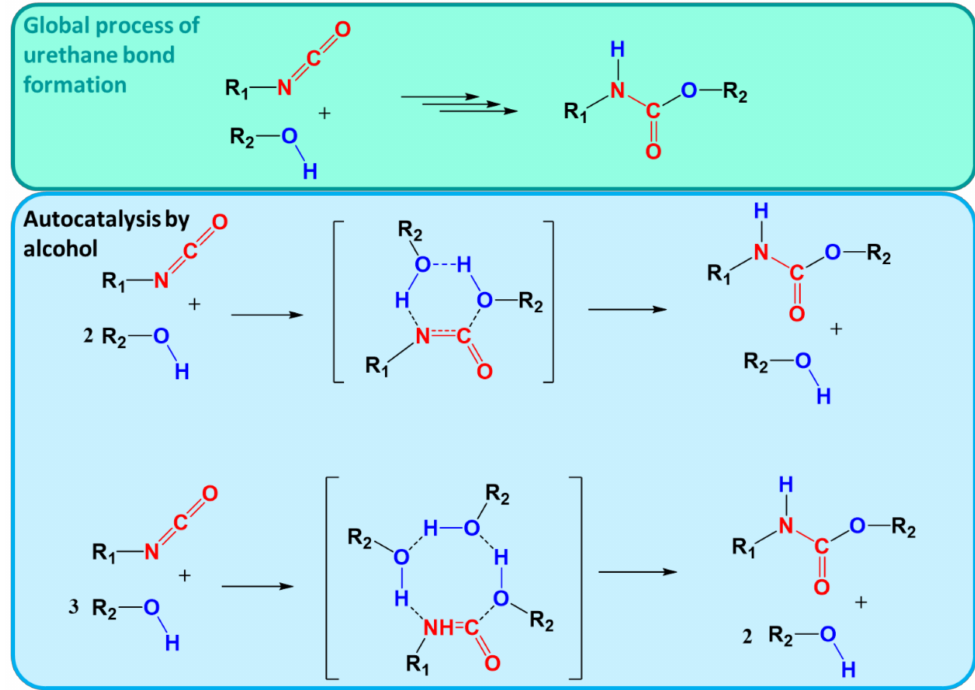
Figure 6. Global reaction of urethane bond formation being the basis of polyurethane step-growth polymerization. Mechanism of autocatalysis by alcohol molecules as explored by Gertig et al.